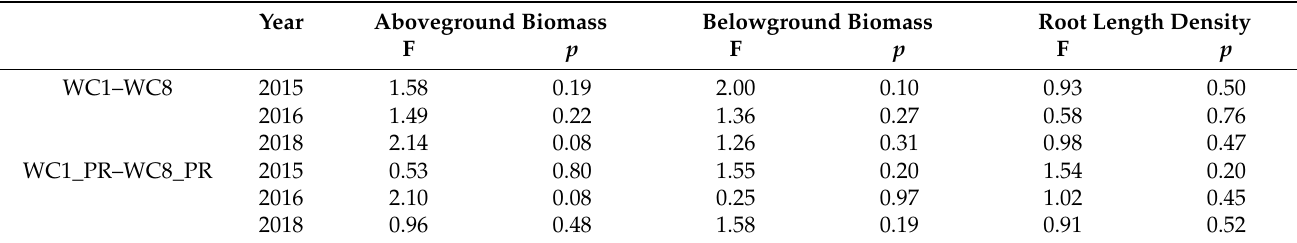
Table 1. One-factorial ANOVA on the significance of the effect of eight different white clover (WC) (WC1–WC8) genotypes on the variance of aboveground biomass, belowground biomass, and root length density of WC1–WC8 monocultures and mixtures of white clover–perennial ryegrass (PR) (WC1_PR–WC8_PR) for 2015, 2016, and 2018. Significance was given at p ≤ 0.05.